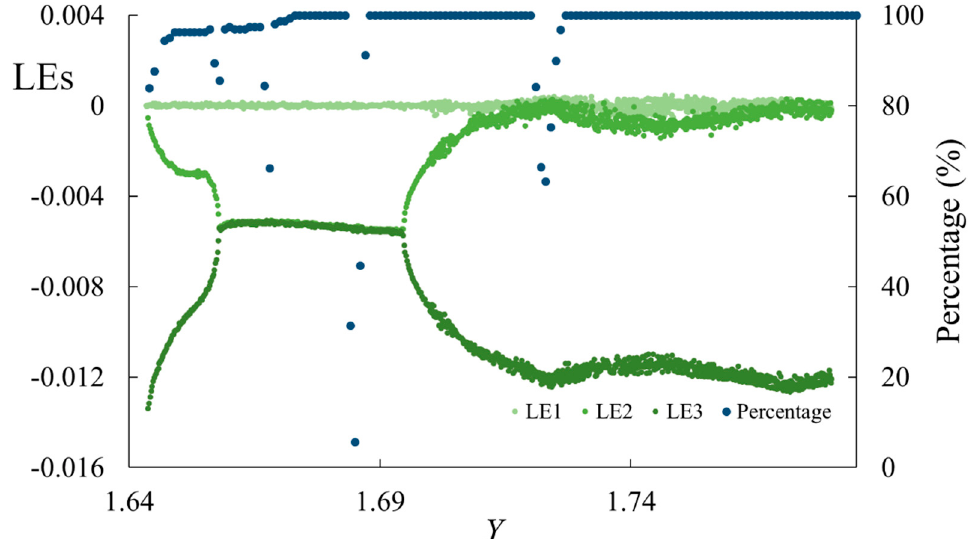
Figure 15. Schematic of LEs vs Y graphed over the partial LE domain of AIII at C = 3.1 and overlayed with the gain-shift results. The right ordinate displays the percentage that AIII survives the gain shift.